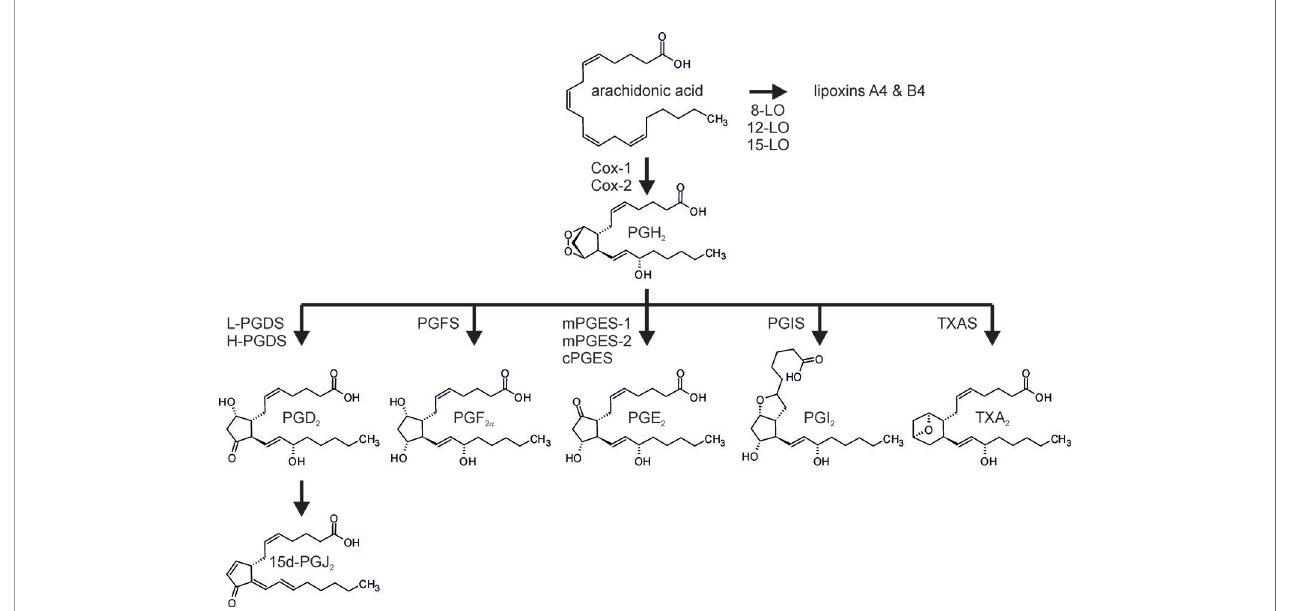
FIGURE 1 | Prostanoid synthesis. Arachidonic acid, liberated from membrane phospholipids by phospholipase A 2 , is converted to prostaglandin H 2 (PGH 2 ) by the dual peroxidase/cyclooxygenase activity of the cyclooxygenases (Cox-1, Cox-2). PGH 2 serves as the substrate for the terminal synthases to produce PGD 2 , PGE 2 , PGF 2 a , PGI 2 , and thromboxane A 2 (TXA 2 ). PGD 2 is further dehydrated and isomerized spontaneously to 15-deoxy − D 12,14 -PGJ 2 (15d-PGJ 2 ). Alternatively, arachidonic acid can be converted to lipoxins, i.e. SPM, via the activity of the lipoxygenases (LO). L-PGDS, lipocalin-type PGD synthase; H-PGDS, hematopoietic-type